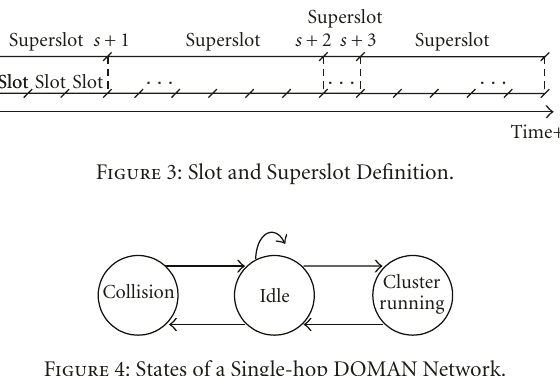
Figure 4: States of a Single-hop DQMAN